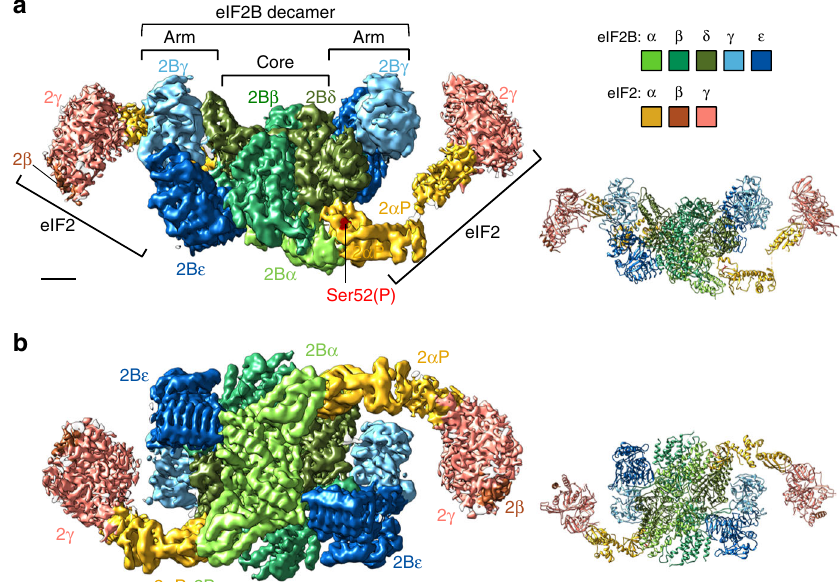
Fig. 1 Electron cryomicroscopy (cryoEM) structure of the eIF2B/eIF2 α P complex. Left: Re fi ned 3.9 Å cryoEM map of eIF2B/eIF2 α P complex with central eIF2B decamer and two lateral eIF2 trimers. Local amplitude scaling (Locscale) was used to apply local density re-scaling based on a fi tted model. Right: modelled densities displayed as secondary structures. a Top and b back views shown. Map surface and subunits are coloured as indicated, with the regulatory phosphoserine in red. Scale bar relates to cryoEM map and is 20 Å. The fi gure was drawn with UCSF Chimera